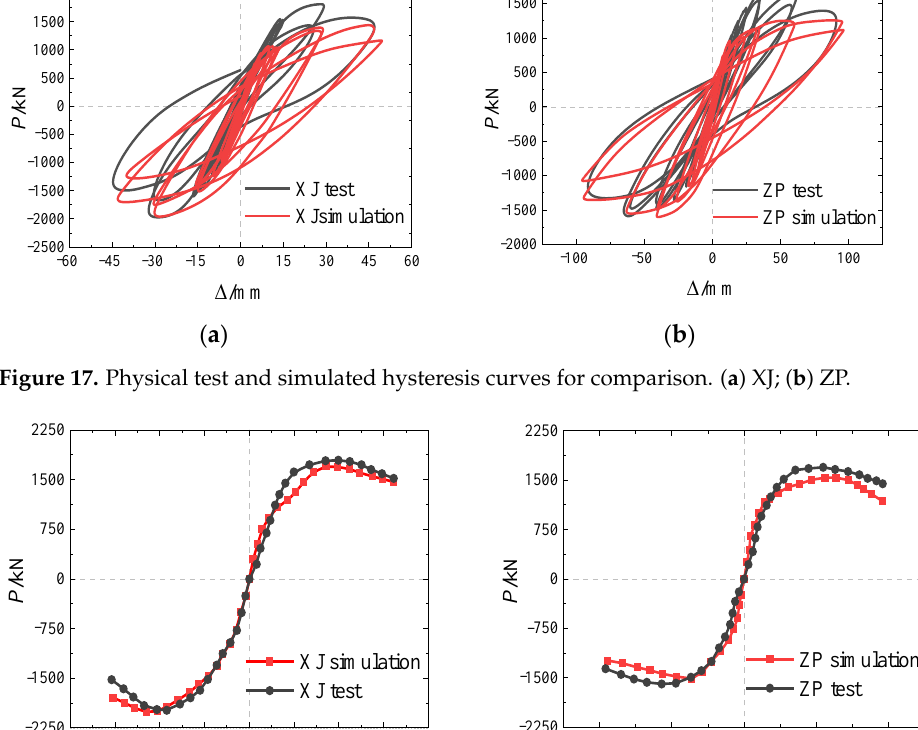
Figure 18. Physical test and simulated load–displacement curves for comparison. ( a ) XJ; ( b ) ZP. Table 6. Comparison results of physical tests and simulation.